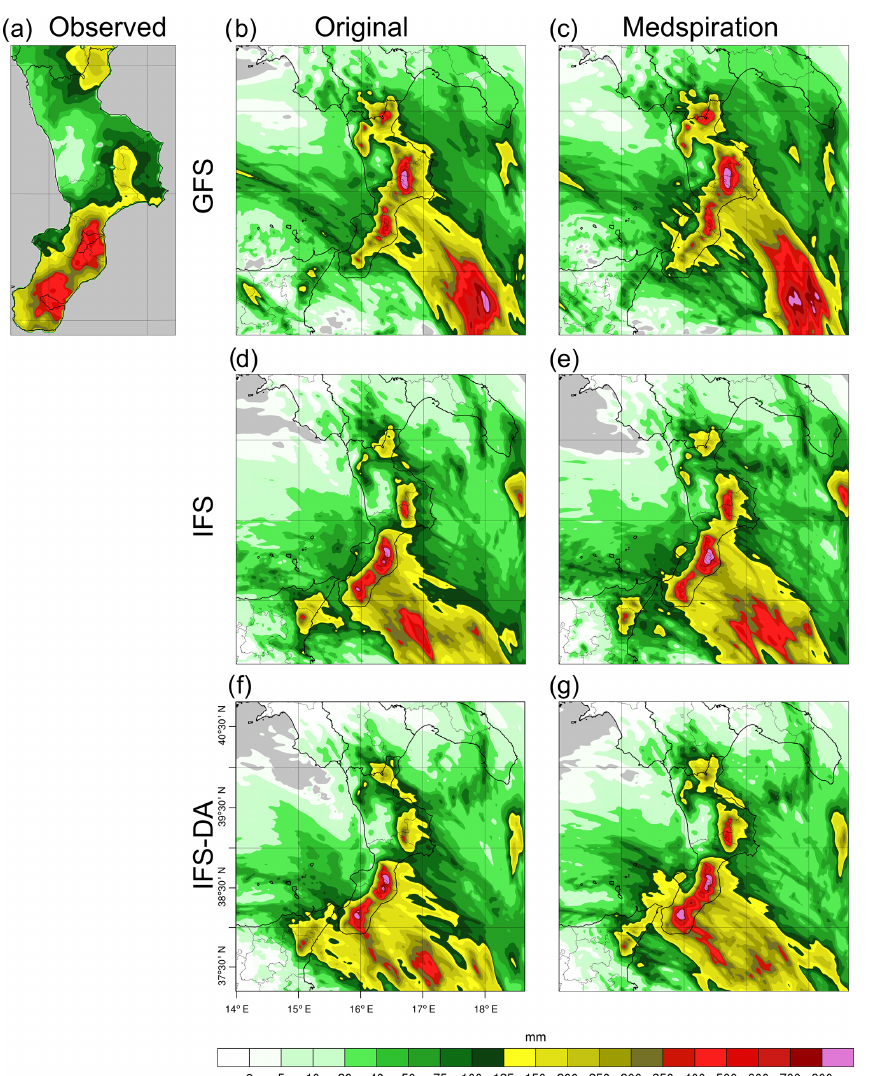
Figure 11. Accumulated precipitation (mm) over the whole period of 96h starting from 00:00UTC on 30 October 2015: (a) merged ground measurements and radar observations; (b–g) simulated fields with the different